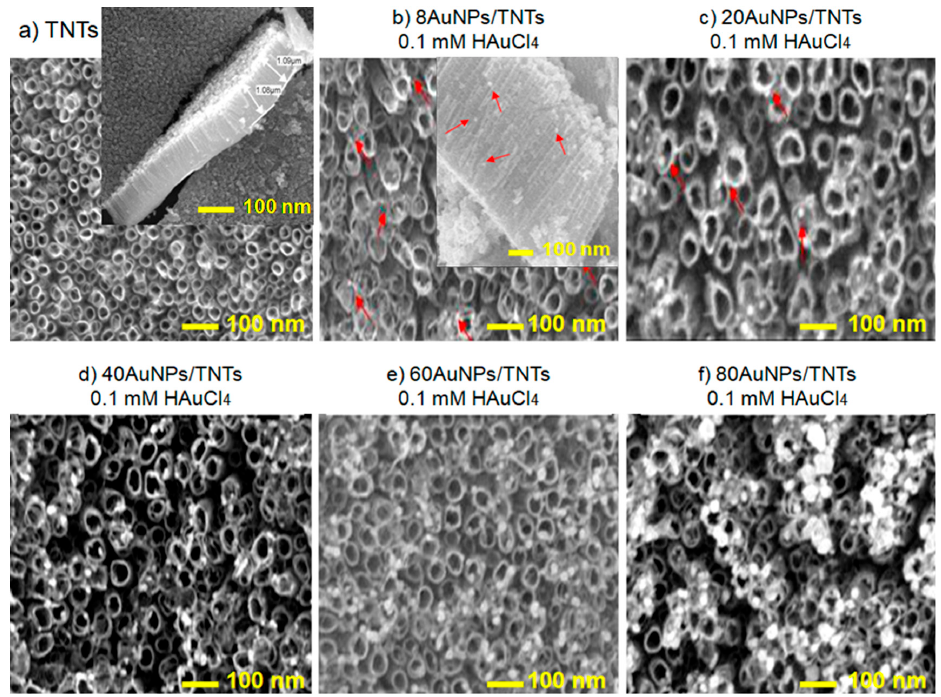
Figure 1. SEM images of TNTs ( a ) after thermal modification anddeposition of AuNPs using CV method carried out in 0.1 mM HAuCl 4 for ( b ) 8 cycles with cross section, ( c ) 20, ( d ) 40, ( e ) 60, and ( f ) 80 cycles.